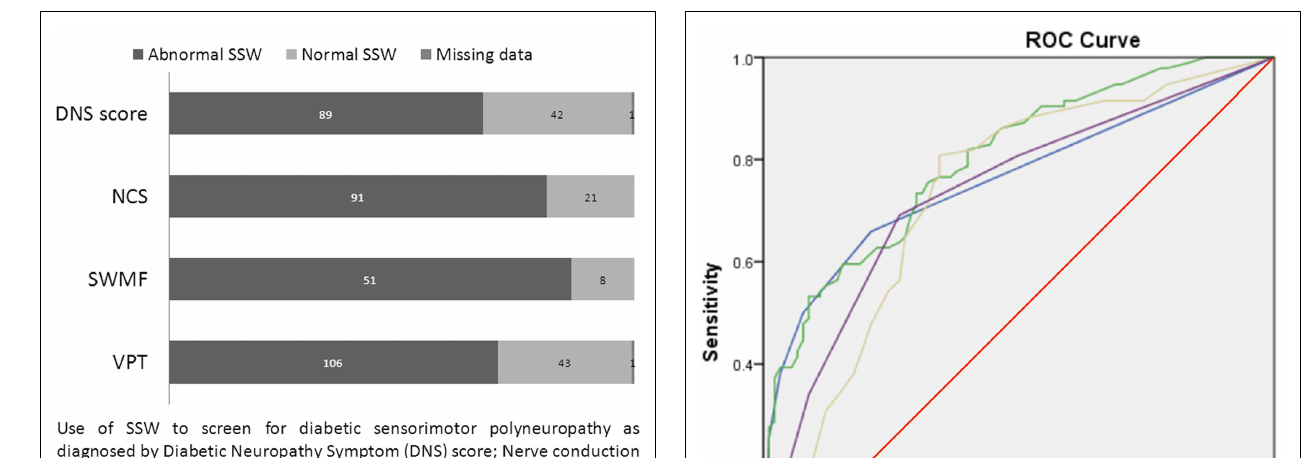
FIGURE 2 | Comparison of stimulated skin wrinkling with other test parameters.